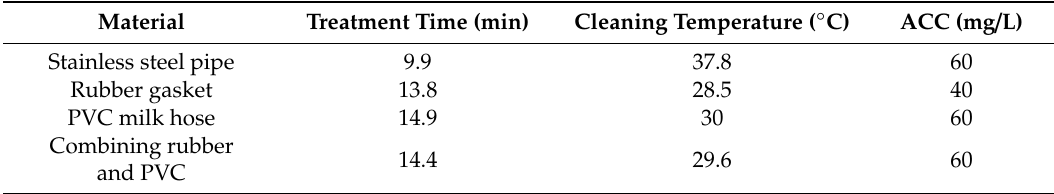
Table 6. Optimized parameters of SAEW treatments predicted by the